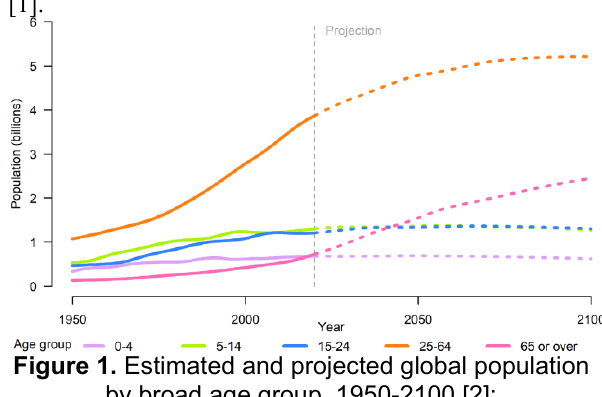
Figure 1. Estimated and projected global population by broad age group, 1950-2100